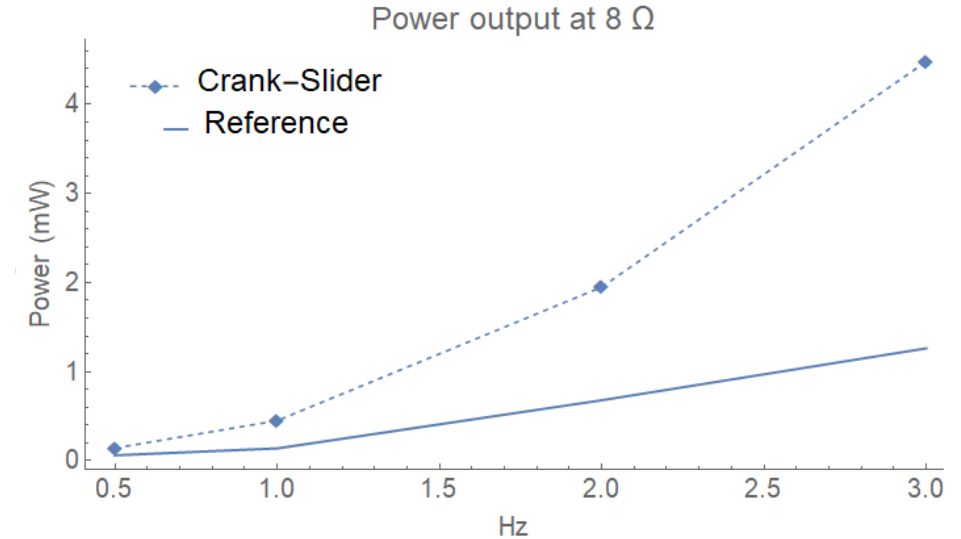
Figure 16. Power output demonstrating that the reference harvester had a lower power output than the crank-slider harvester at 0.5, 1, 2, and 3 Hz with a 8.4 Ω load.